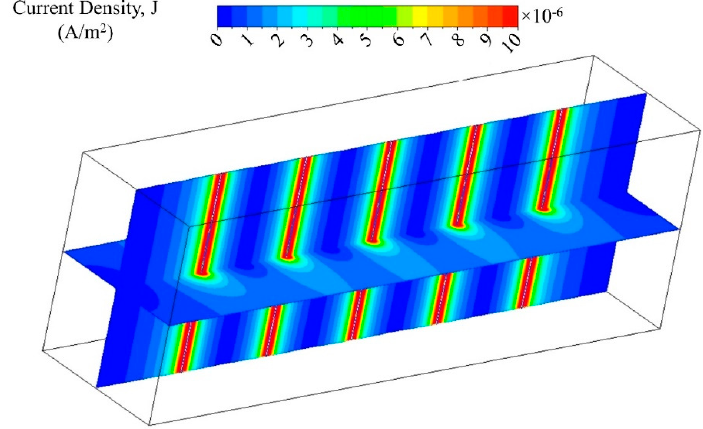
Figure 8. Distribution of current density (J) magnitude at the midplanes in the case of d w = 1 mm, 45 kV, and U in = 2 m/s in the 230 mm wide channel.